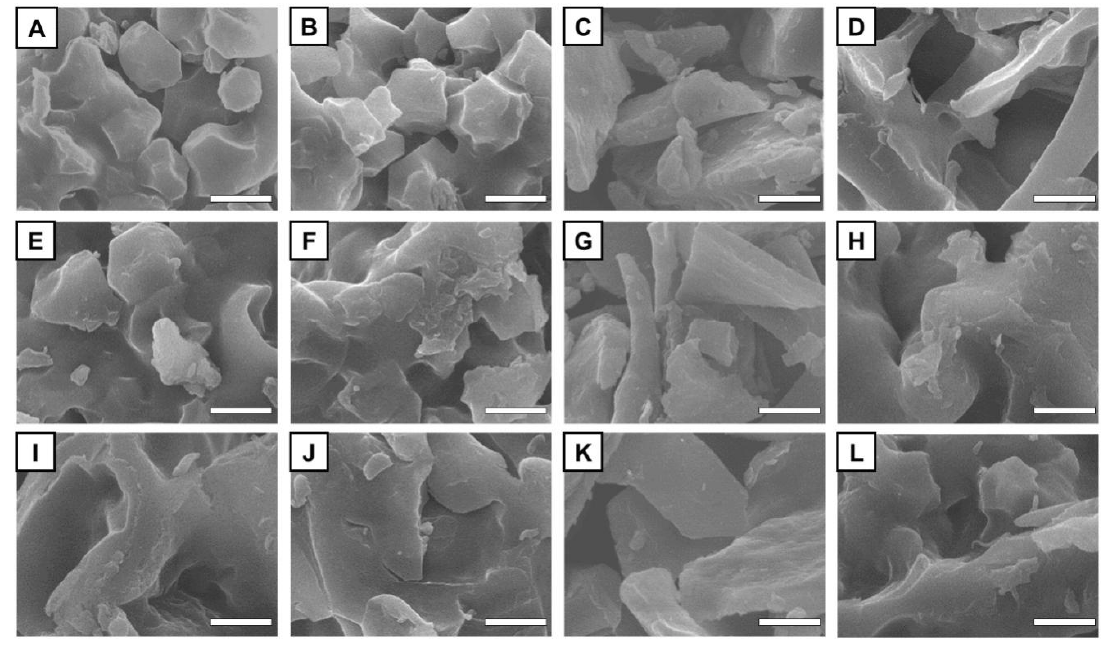
Figure 1. SEM images of PGSs reheated by different methods. (( A ): LGS; ( B ): LGS-HM; ( C ): LSG-LM; ( D ): LGSW; ( E ): MGS; ( F ): MGS-HM; ( G ): MGS-LM; ( H ): MGSW; ( I ): HGS; ( J ): HGS-HM; ( K ): HGS-LM; ( L ): HGSW). Scale bars = 5 μ m.